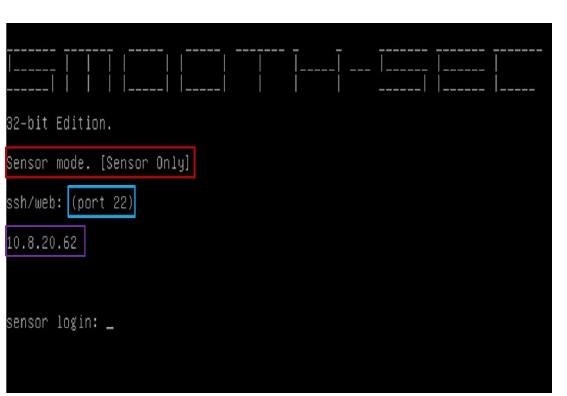
Fig. 10: Smooth-Sec installed as Sensor